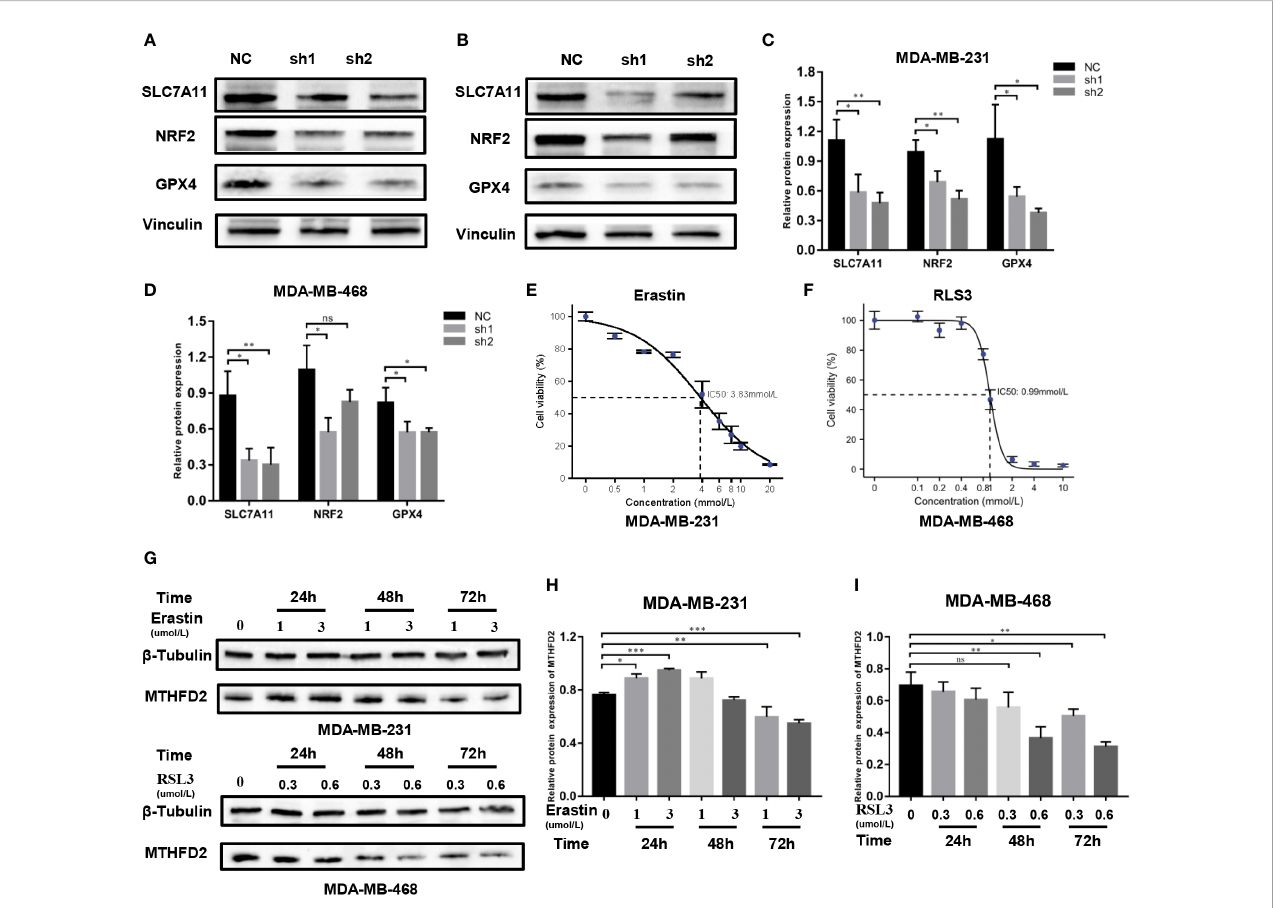
FIGURE 11 Regulatory mechanisms of MTHFD2 in ferroptosis. (A-D) Western blot assays were used to detect the expression of ferroptosis-related proteins in MDA- MB-231 and MDA-MB-468 cell lines. (E) IC50 of erastin in the MDA-MB-231 cell line (detected by CCK8 assay); the IC50 is approximately 3.83 µm/L. (F) IC50 of RLS3 in the MDA-MB-468 cell line (detected by CCK8 assay); the IC50 is approximately 0.99um/L. (G-I) Expression of MTHFD2 in MDA-MB- 231 and MDA-MB-468 after erastin or RLS3 treatment (detected by Western blot assays). ns: p ≥ 0.05, * p <0.05, ** p <0.01, *** p <0.001, **** p